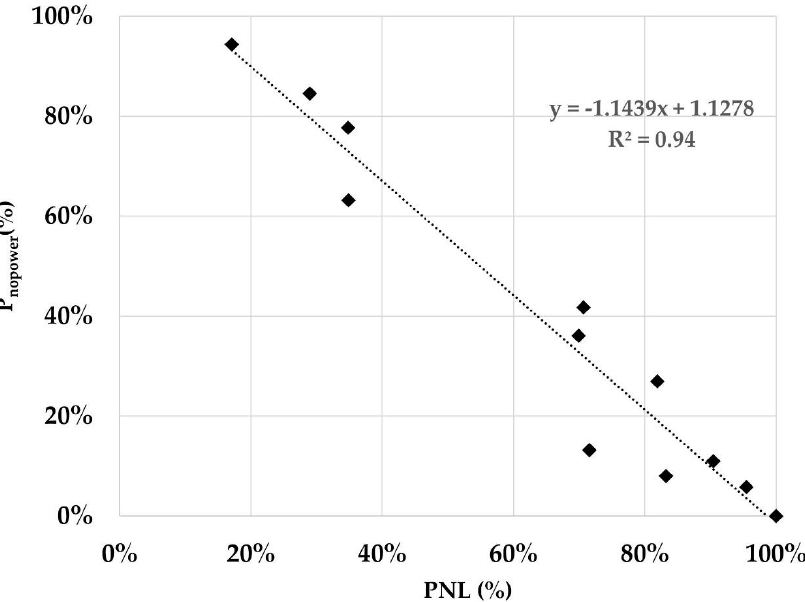
Figure 6. The correlation between PNL and the percent of customers without power (P nopower ) in Puerto Rico.